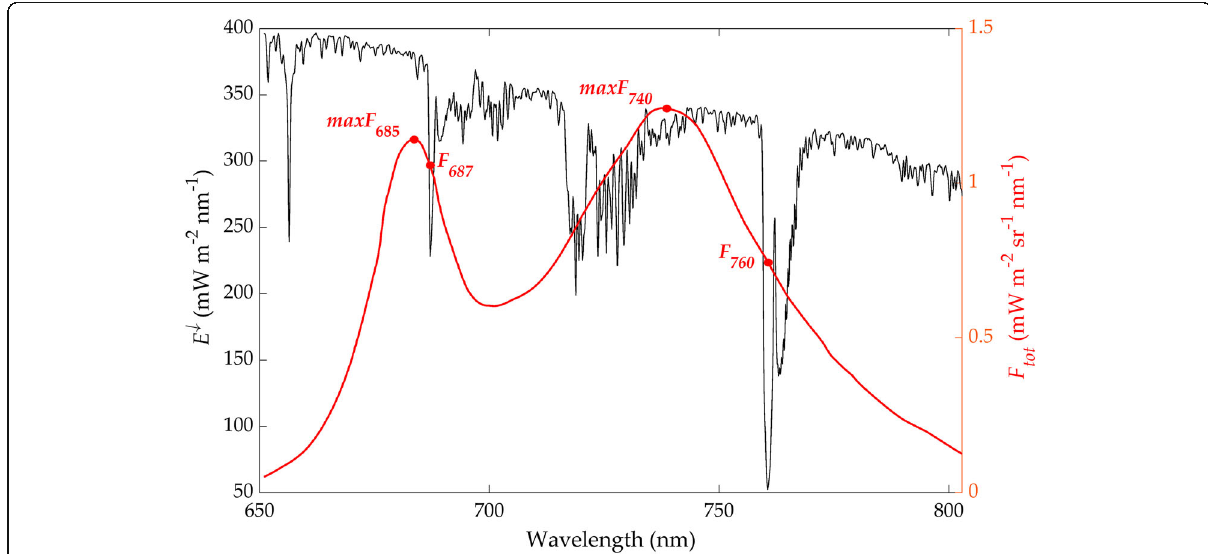
Fig. 13 The black line shows irradiance at ground level and the red line shows a typical chlorophyll fluorescence spectrum, with fluorescence peaks at 685nm and 740nm (maxF685, maxF740). Solar-induced fluorescence (SIF) is estimated at the closest Fraunhofer lines to these maxima, located within the O 2 B lines centered at 687nm and O 2 A lines centered at 760nm (F687, F760). Figure with permission from Cendrero-Mateo et al.